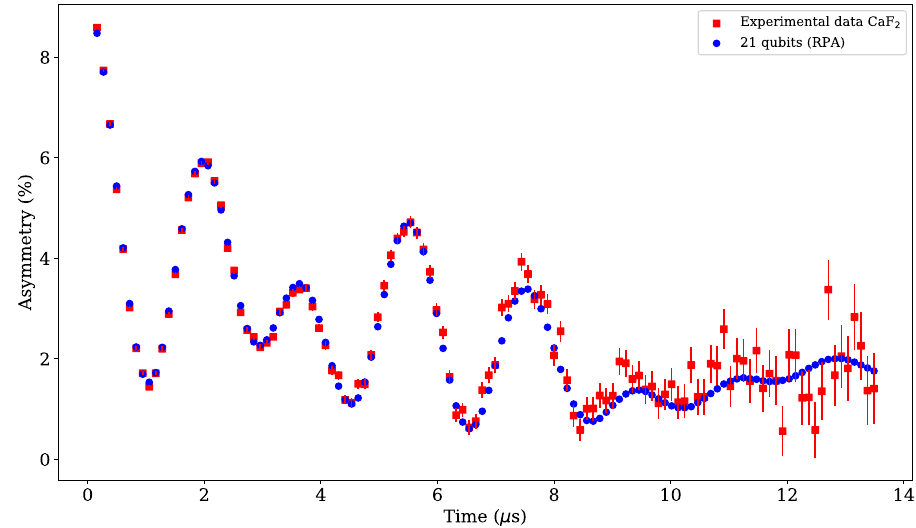
FIG. 11. Fit of the 21-qubit simulated data (using the random-phase-approximation method with one sample per data point, and 40 second-order Trotter steps) to the experimental data obtained in Ref. [9]. The fit is performed using the gradient-free Nelder-Mead algorithm. The fitting parameters are the muon-fluorine distances described in the main text, and a scaling factor and offset to convert the simulated polarization value to an asymmetry value.